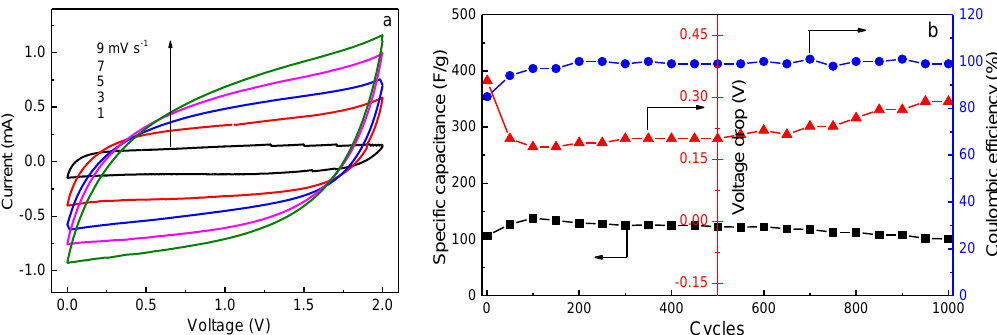
Table 3. Specific capacitance, energy density, and power density of the EDLC at a current density of 0.4 A g – 1 under a working voltage of 2 V.